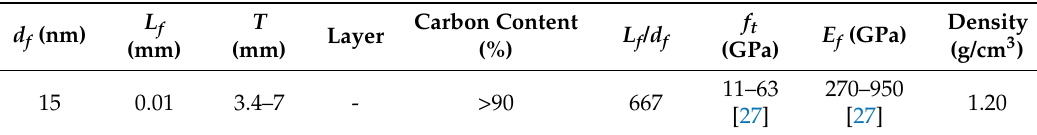
Figure 1. Fabrication process of UHPFRC specimens: ( a ) casting method; and ( b ) direction of copper plates according to casting direction. Table 4. Properties of